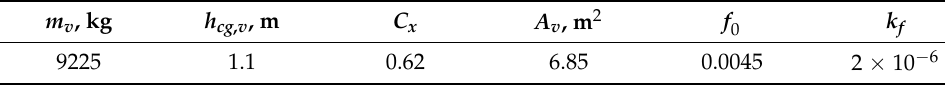
Table 2. Main parameters of the simulated